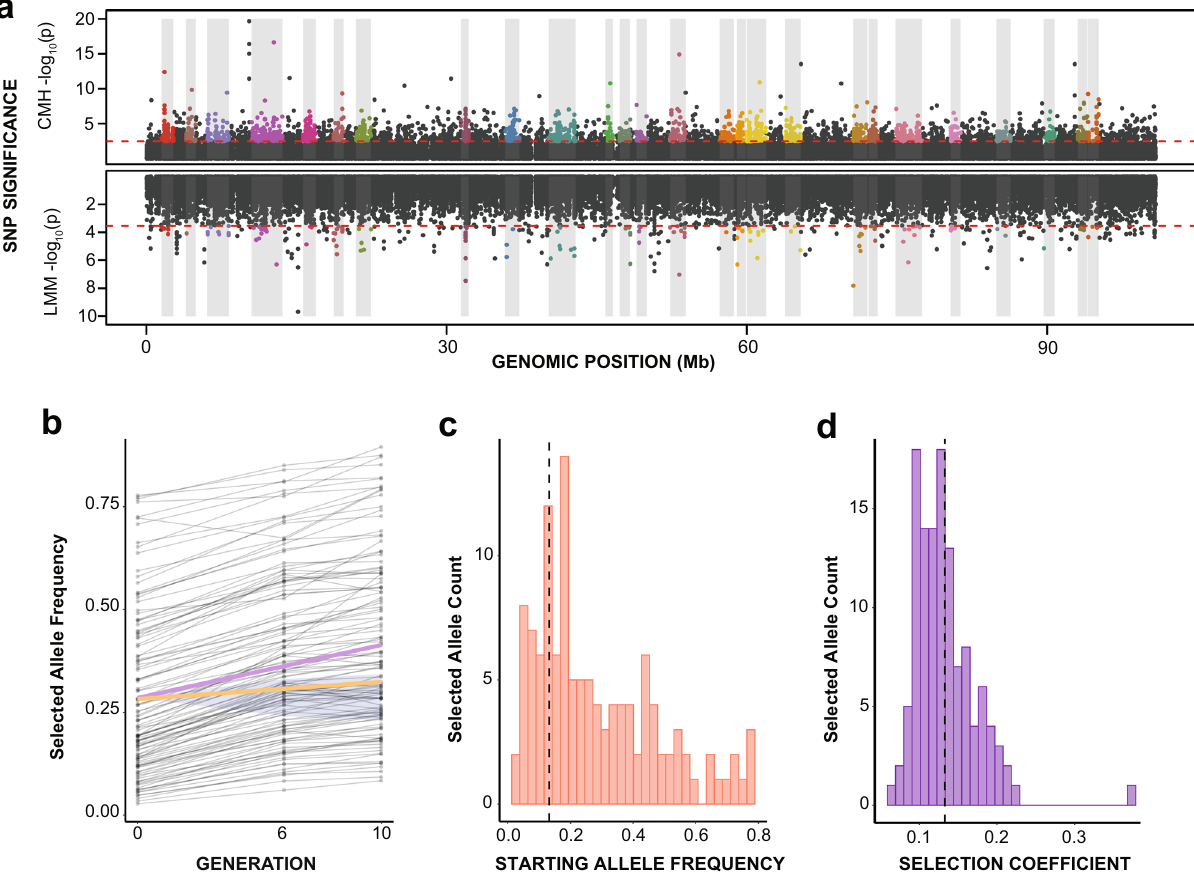
Fig. 1 Genomic signatures of laboratory selection in response to salinity decline. a Manhattan plot of single-nucleotide polymorphism (SNP) signatures of selection on one arbitrarily selected genomic scaffold. SNPs above the dotted red line were deemed signi fi cant (adjusted P < 0.05). SNPs are colored according to the selected haplotype block in which they were grouped, and shaded gray boxes delineate the 26 haplotype blocks on this scaffold. Top — Cochran-Mantel-Haezel (CMH) test for signi fi cant allele frequency changes beyond expectations from genetic drift. Bottom — linear mixed model (LMM) test to distinguish allele frequency trajectories between treatment and control lines. b Selected allele frequency trajectories during laboratory selection. Gray lines represent mean allele frequencies across the ten replicate lines (eight at generation ten) for each selected allele (i.e., haplotype block, N = 121). The purple line shows the average frequency for all selected alleles in the treatment lines. The yellow line shows the average frequency for all selected alleles in the control lines. The blue shaded area is the 1% and 99% quantile range of allele frequencies from 10,000 neutral simulations starting from the average starting frequency of the selected alleles. c Histogram of selected allele frequencies in the starting population, polarized to show the rising allele. The dotted line represents the mean frequency. d Histogram of selection coef fi cients of selected alleles, estimated using the change in frequency after ten generations across the replicate treatment lines. The dotted line represents the